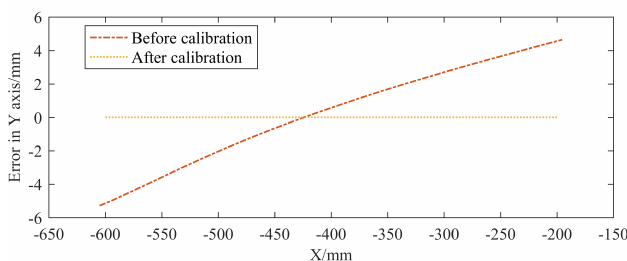
Figure 6. Trajectory errors relative to the ideal situation: linear